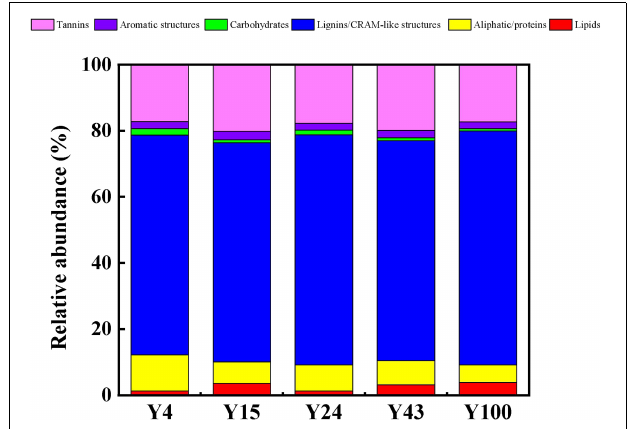
FIGURE 3 | Comparison of the composition of soil dissolved organic matter (DOM) from different stand ages of Chinese fir